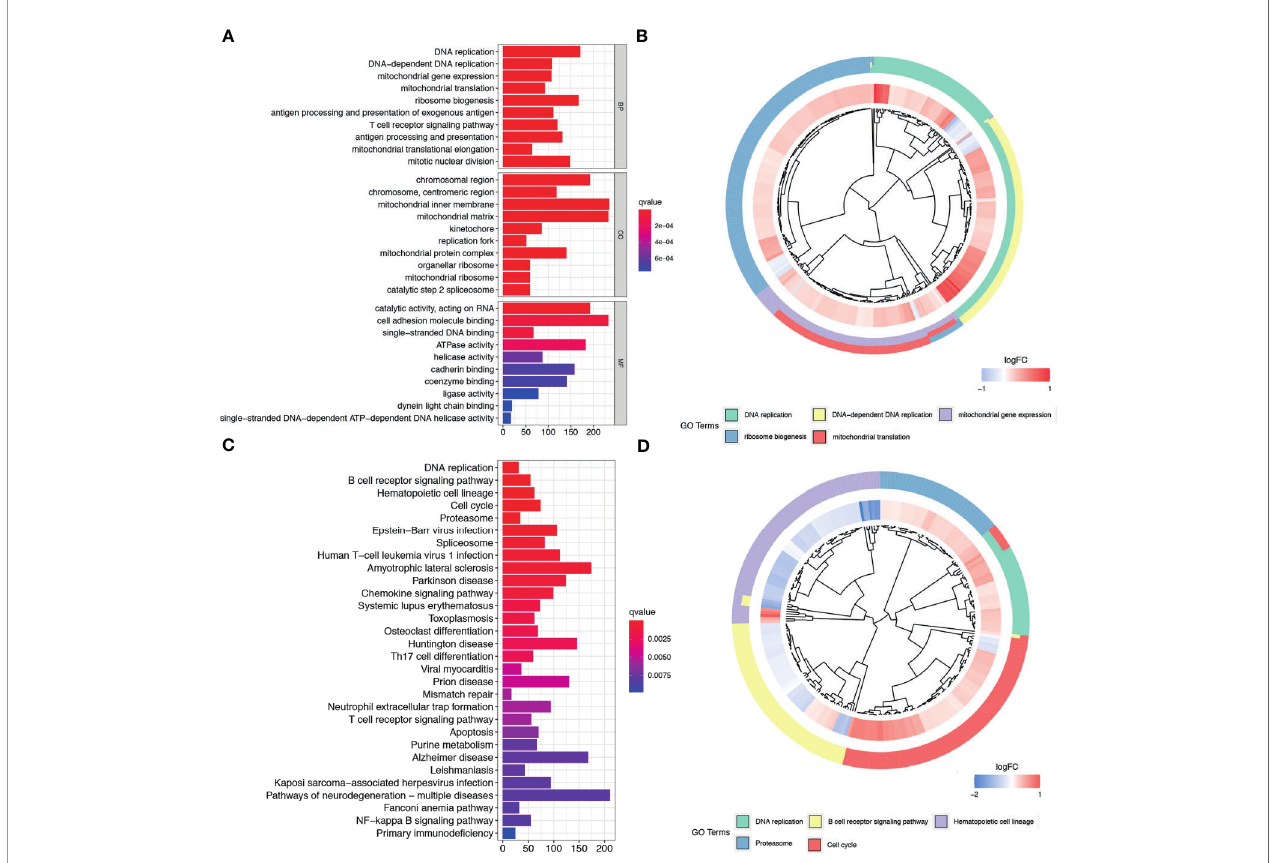
FIGURE 4 | Further comparison between high- and low-risk groups of the TCGA cohort. (A) and (B) show the bar plot and cluster plot of signi fi cant GO functional items, respectively. (C) and (D) show the bar plot and cluster plot of signi fi cant KEGG pathways,